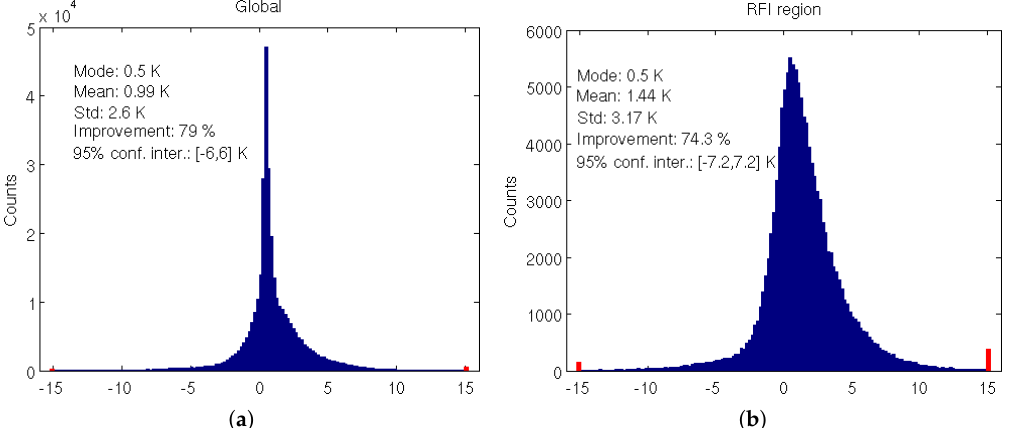
Figure 17. Histogram of the difference between error standard deviation of nominal TB and error standard deviation of NS TB after the adjustment detailed in this section (mean error std: 1 K): those points with error standard deviations higher than 15 K in absolute value are accounted for in the red bars (excess bars). ( a ) Global; ( b ) RFI